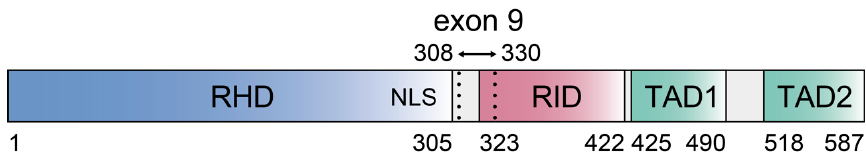
Figure 1. Human c-Rel protein domains—schematic illustration. Amino acid start and end points of represented protein domains are indicated by numbers below the scheme. The position of the amino acid sequence encoded by exon 9 (aa 308–330) is highlighted by dotted lines. RHD, Rel homology domain; RID, Rel inhibitory domain; TAD, transactivation domain; NLS, nuclear localization signal. This figure is based on [9,15]. Other references assign the RHD to aa 8–290 [21] or aa 8–297 (UniProt